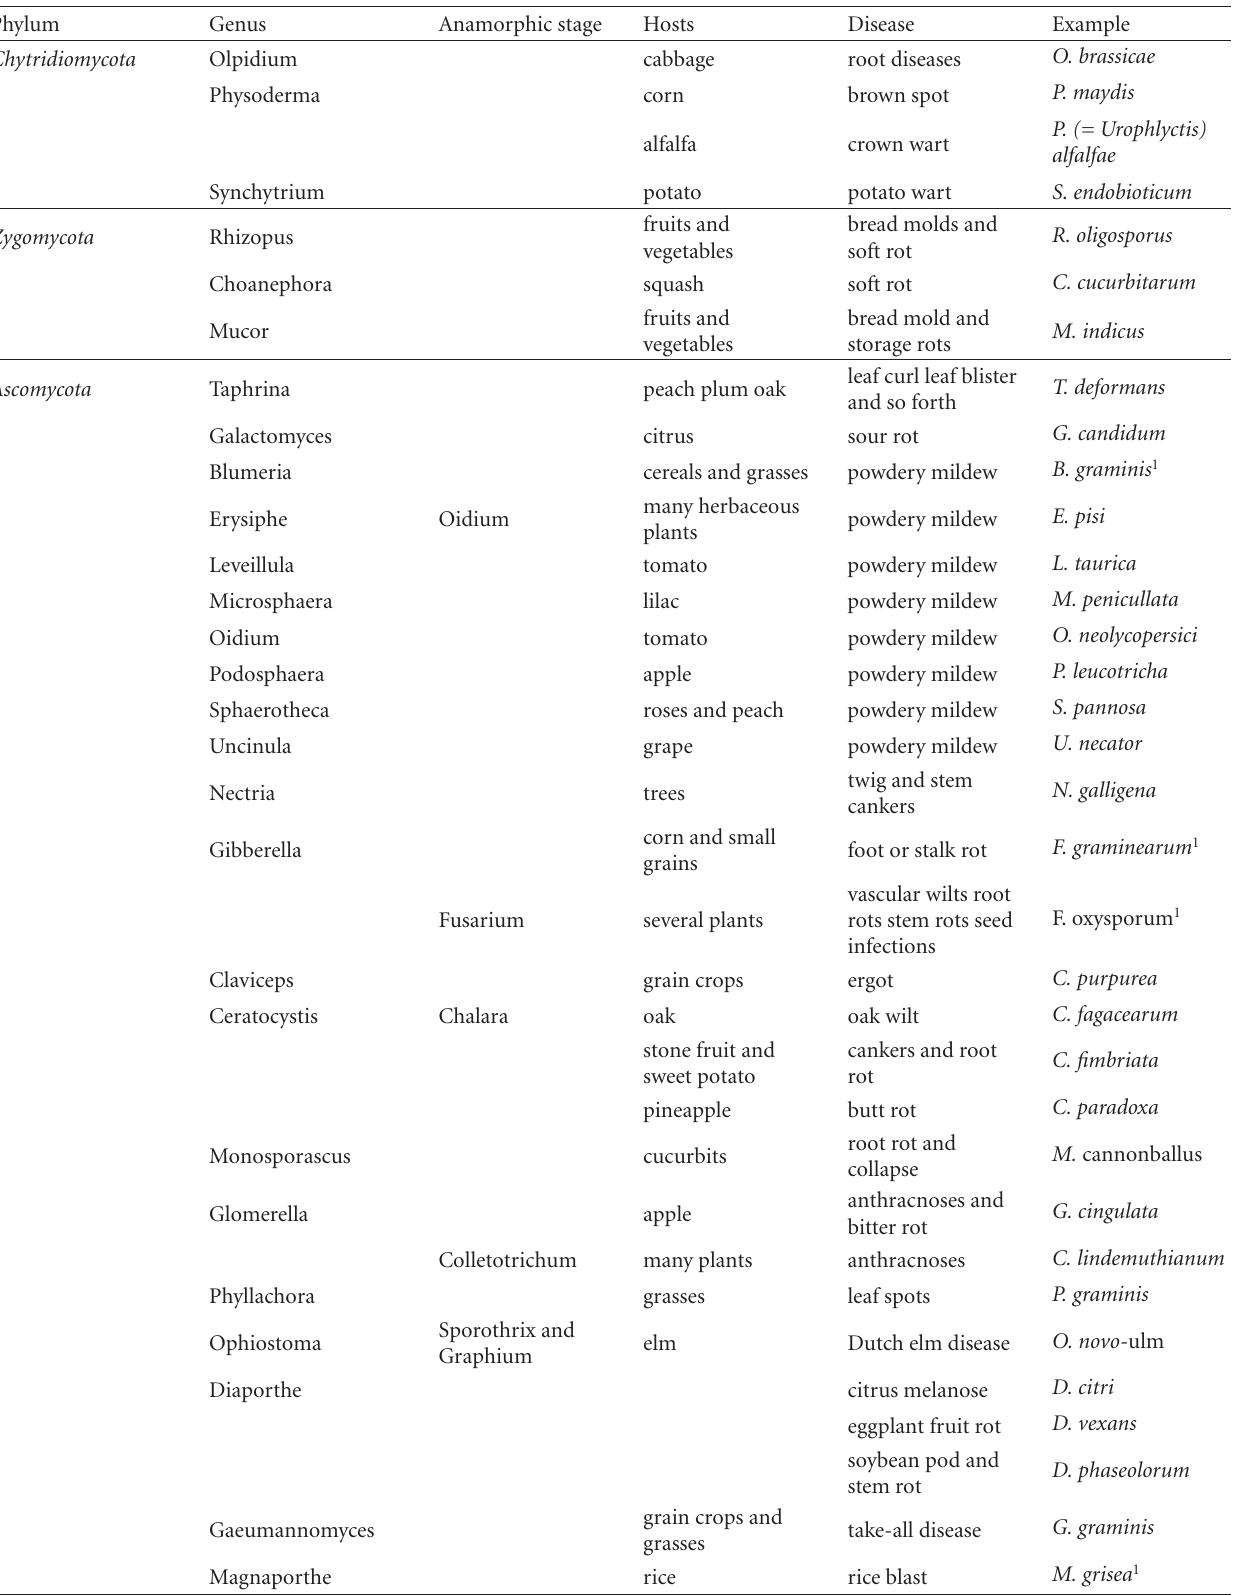
Table 1: Main plant pathogenic fungi causing disease in